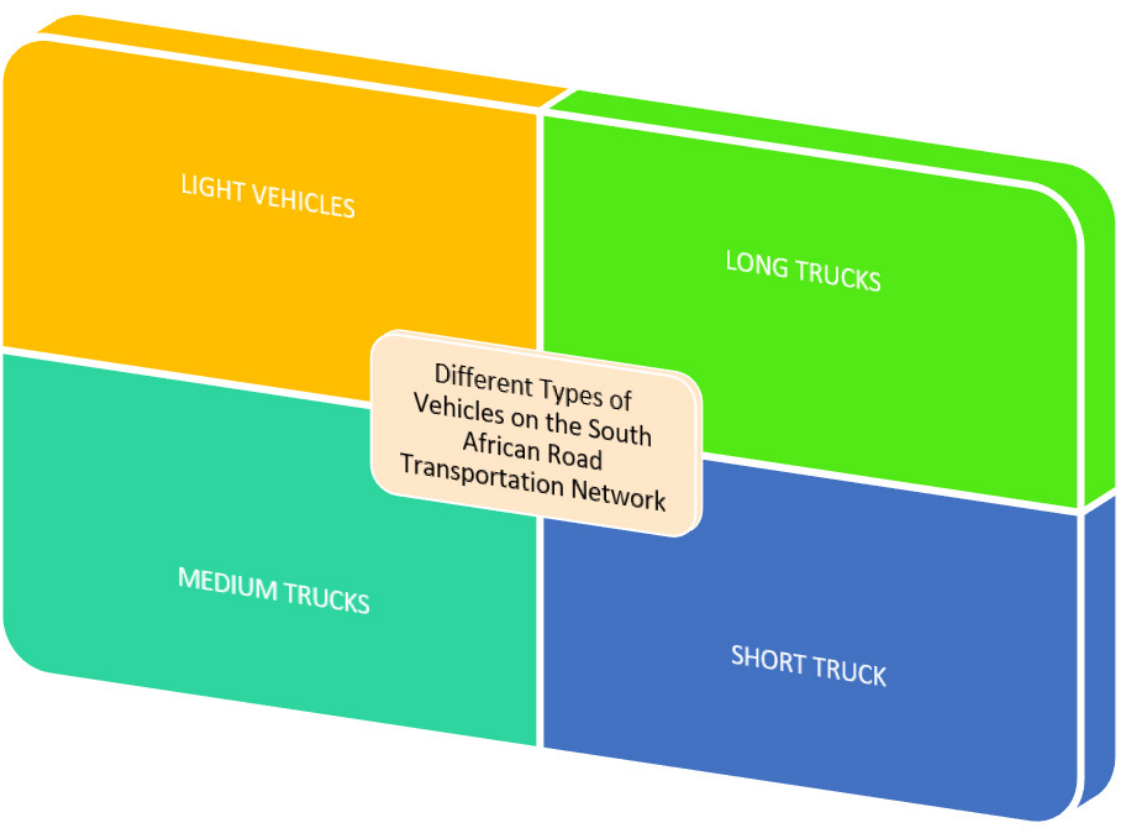
Table 1. Categorization of the traffic datasets into inputs and output.